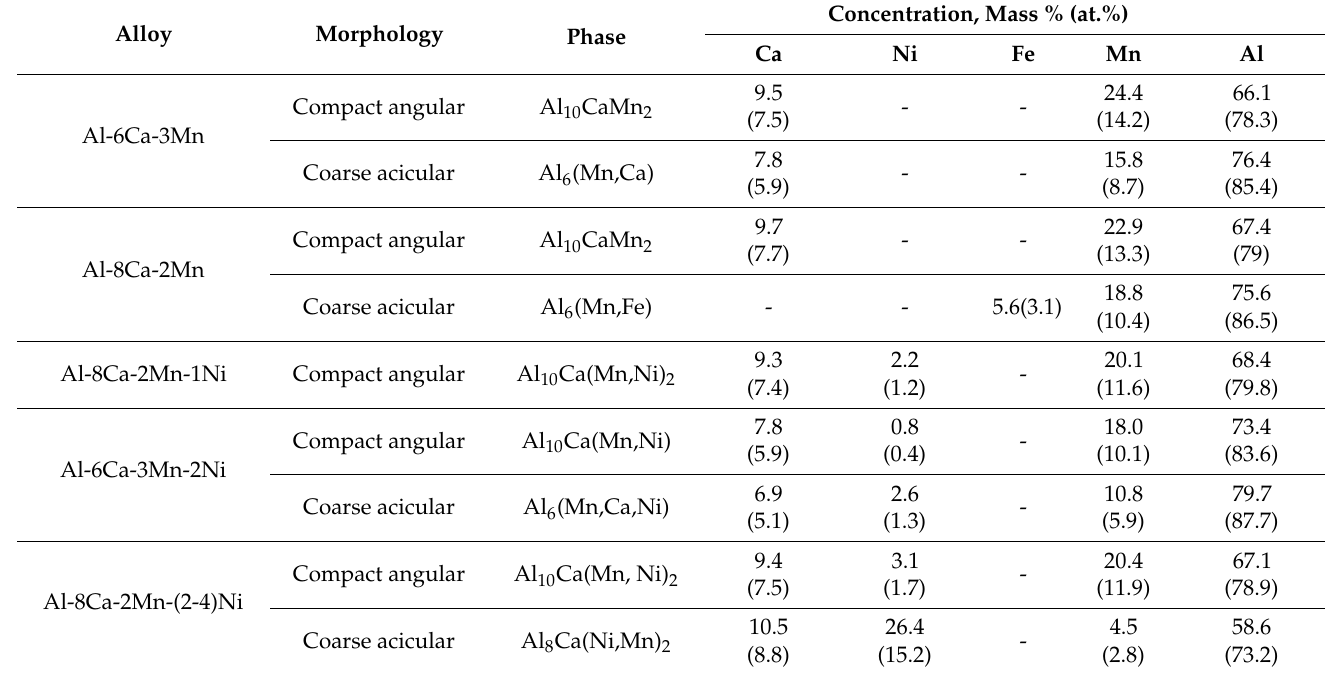
Table 4. Composition of primary crystals according to EMPA